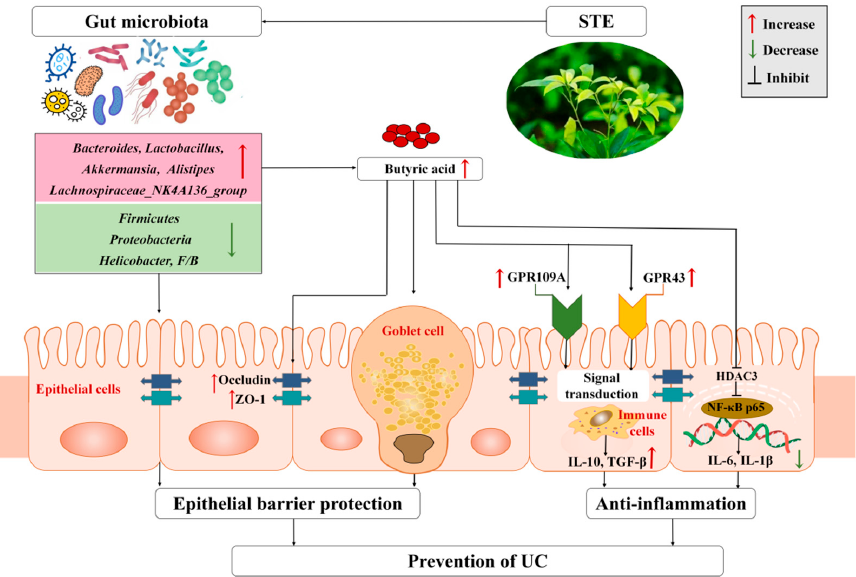
Figure 7. Mechanism of STE to attenuate DSS-induced ulcerative colitis through microbiota and their metabolites. ZO-1, zonula occludens-1; GPR109A, G-protein-coupled receptor 109A; GPR43, G-protein-coupled receptor 43; IL-10, interleukin-10; TGF- β , transforming growth factor- β ; HDAC3, histone deacetylase 3; NF- κ B p65, nuclear factor- κ B p65; TNF- α , tumor necrosis factor-alpha; IL-6, interleukin-6; IL-1 β , interleukin-1 β ; UC, ulcerative colitis; STE, sweet tea extract.